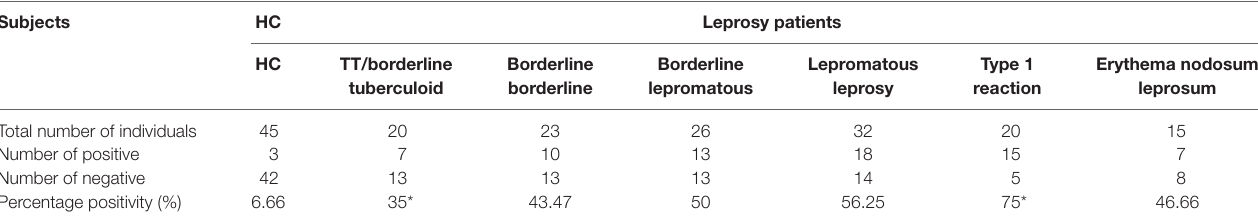
TaBle 1 | Sero-positivity of anti-myosin antibodies in sera of leprosy patients and healthy controls (HC). subjects hc